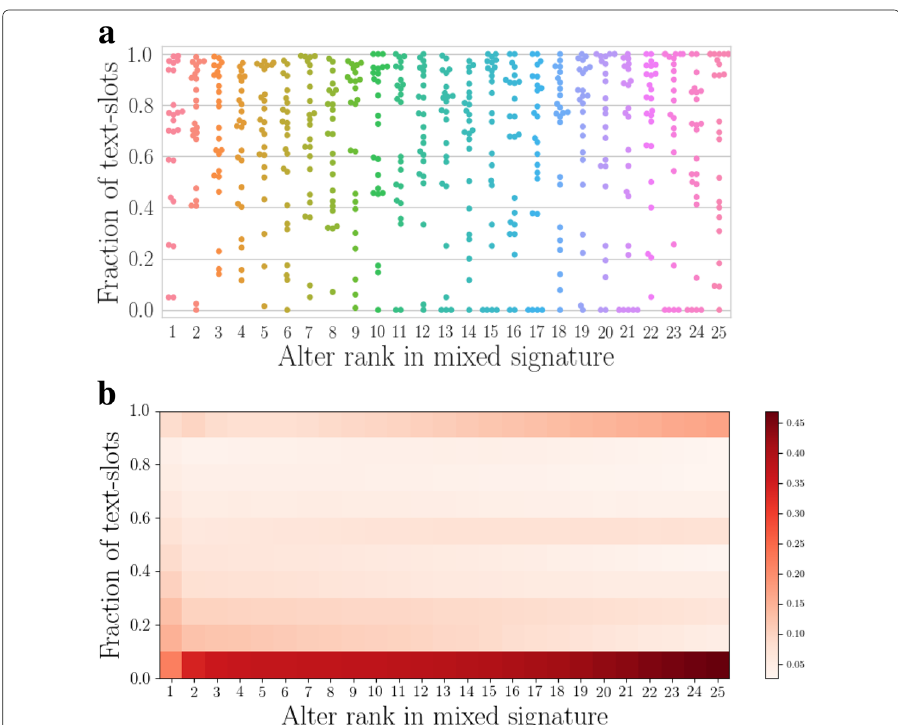
Fig. 6 Share of Text in the Communication. Top a : Each dot shows the fraction of text slots in an ego-alter relationship as a function of rank, for the smaller DS2. The plot contains all ego-alter pairs. There appears to be no general pattern, except that the top ranks are mostly occupied by alters who are both called and texted, while in the tails of the signature (ranks > 10 or so), there are more alters who are only texted or called. Bottom ( b : A heat-map version of the top panel for DS1, with colors indicating the number of ego-alter pairs with a given fraction of texts at each rank in DS1. In this dataset, texts are used much less than in